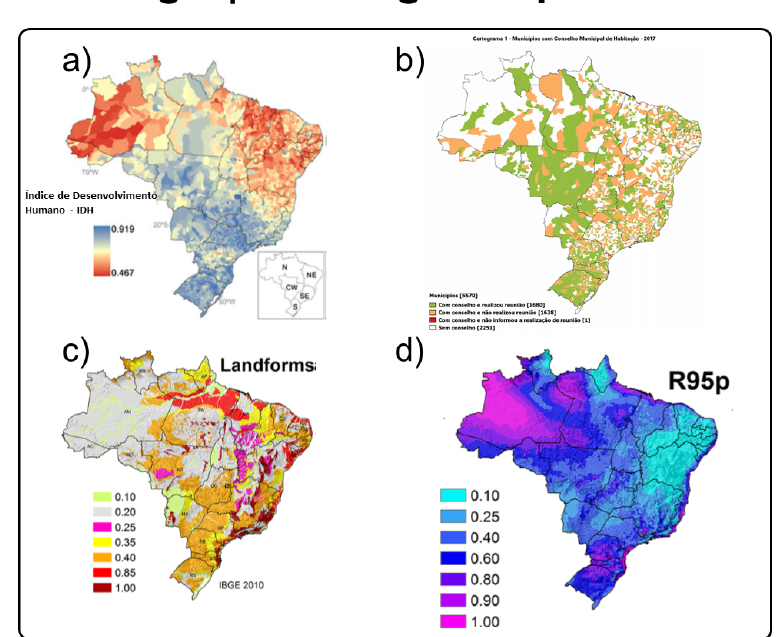
Figure A18. Package of maps used in the fourth training for mapping climate risk associated with floods. The maps illustrate (a) Human Development Index (HDI; Torres et al., 2012), (b) municipal housing council (IBGE, 2017), (c) landforms (Debortoli et al., 2017), and (d) annual total precipitation when rainfall > 95th percentile (R95p; Debortoli et al., 2017).